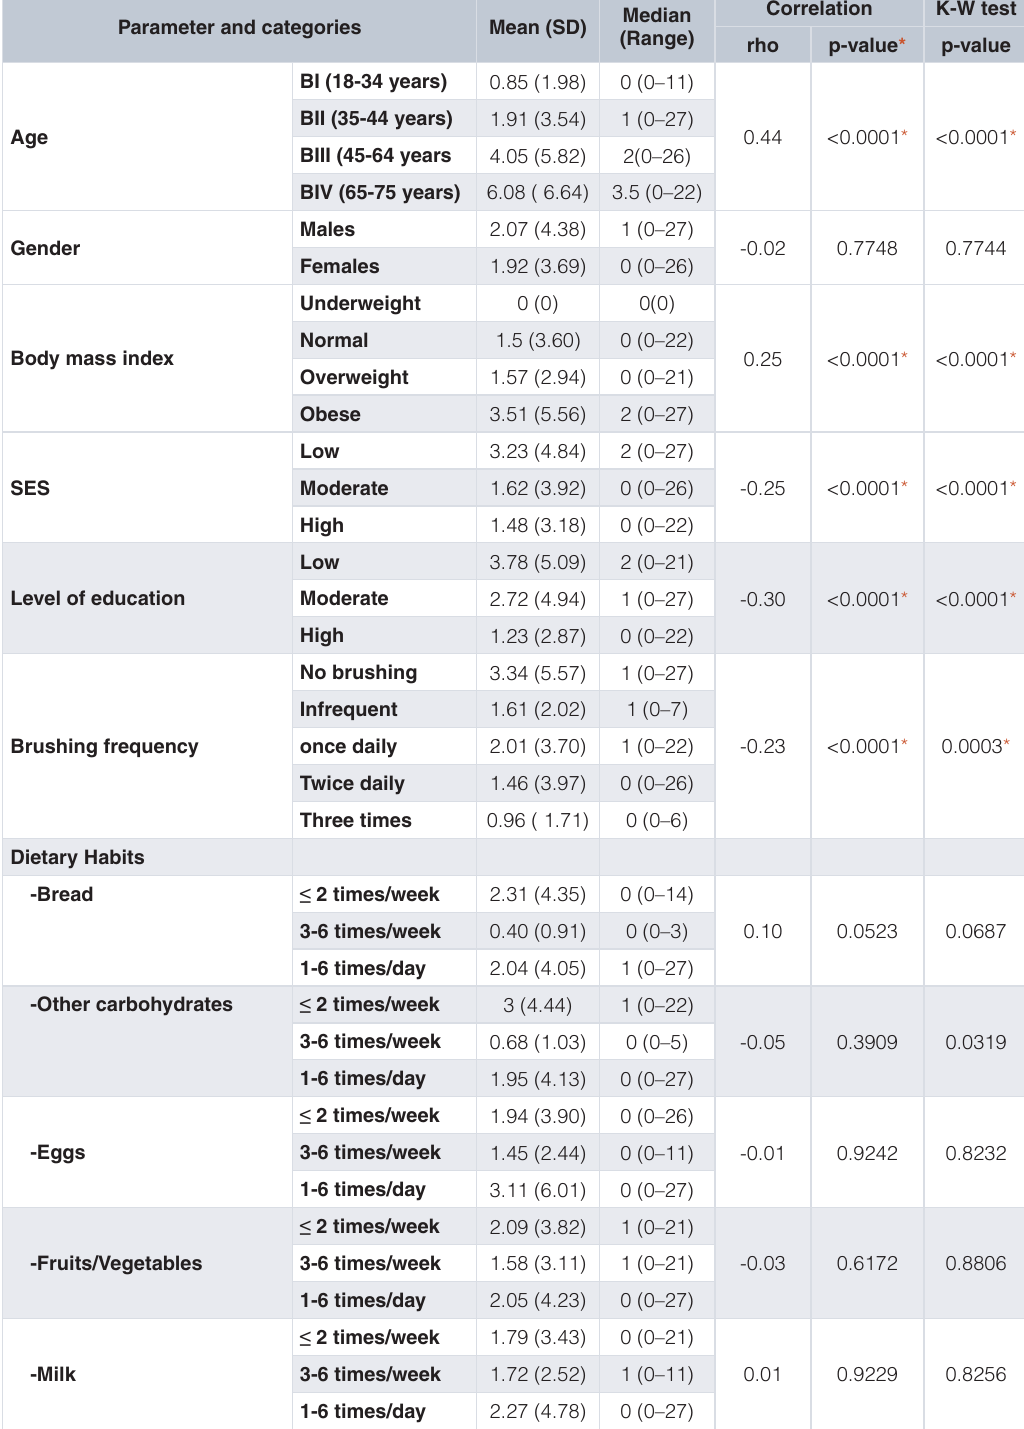
Table 4. Missed teeth and different risk factors